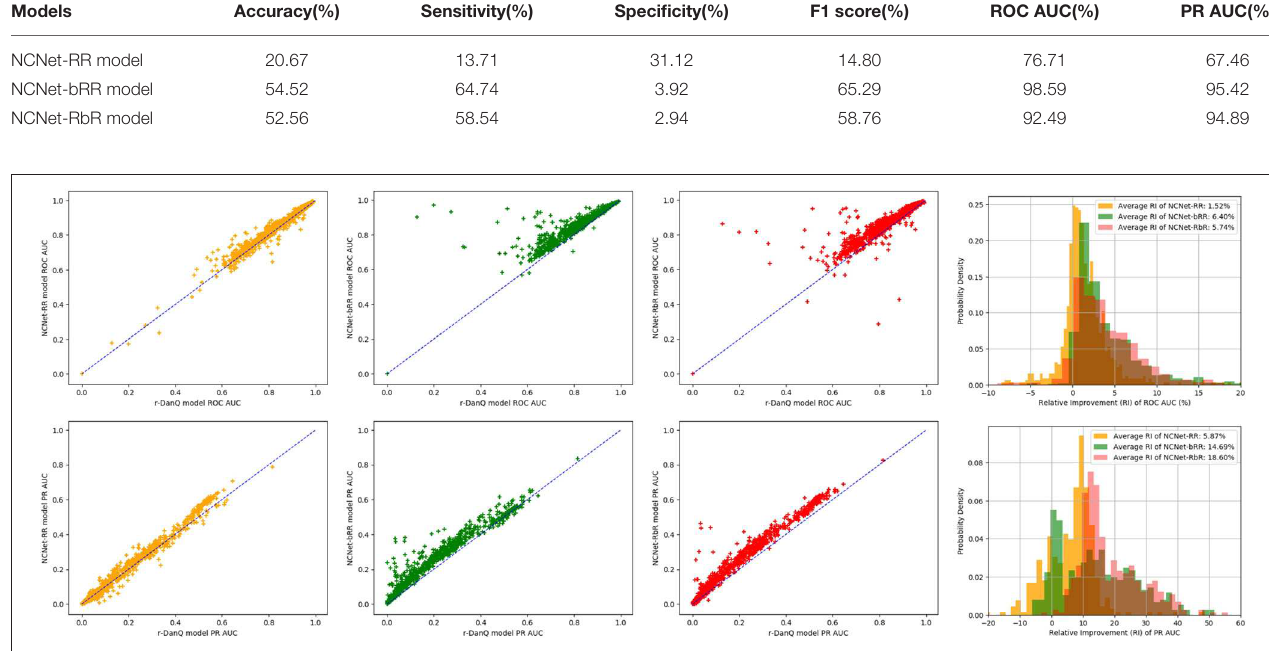
FIGURE 6 | Scatter comparison to r-DanQ model for ROC AUC (Top) and PR AUC (Bottom) of NCNet-RR model (First), NCNet-bRR model (Second), NCNet-RbR model (Third) and an overlapped histogram of relative improvements for the three NCNet models (Forth).